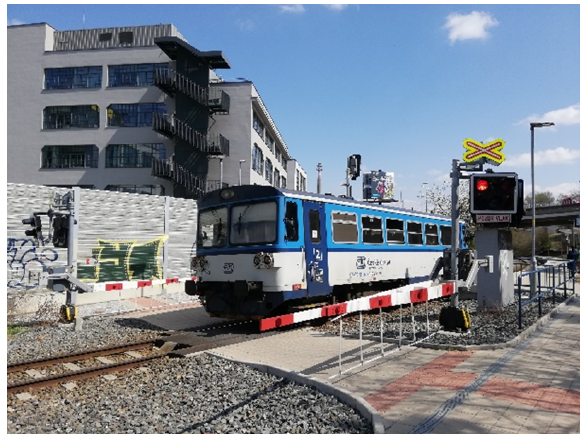
Figure 2. Railway crossing for pedestrian, Prague 5 – Jinonice.